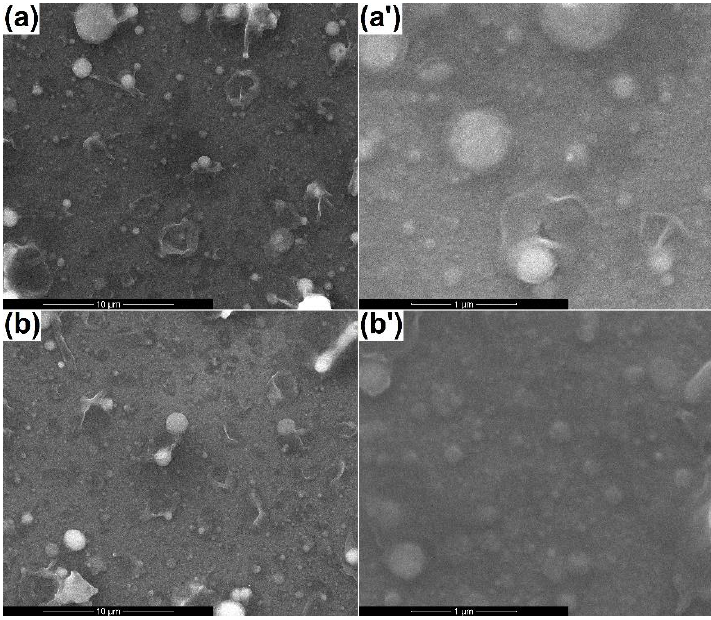
Figure 4. SEM images of the coatings processed at ( a -10,000 × and a’ -80,000 × ) room temperature and ( b -10,000 × and b’ -80,000 × ) 300 °C.